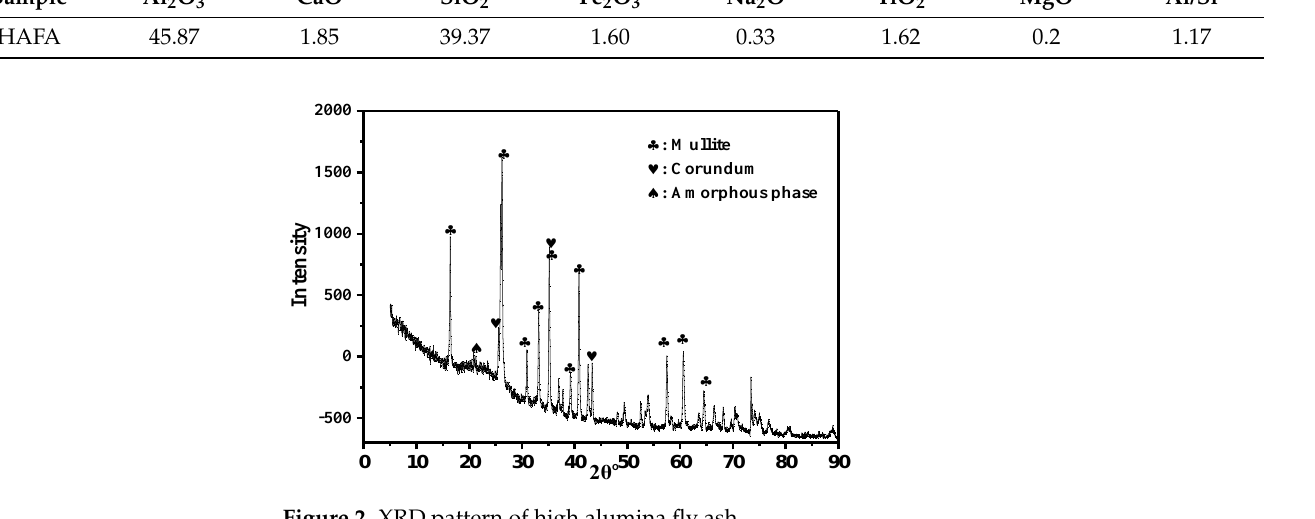
Figure 2. XRD pattern of high alumina fly ash.